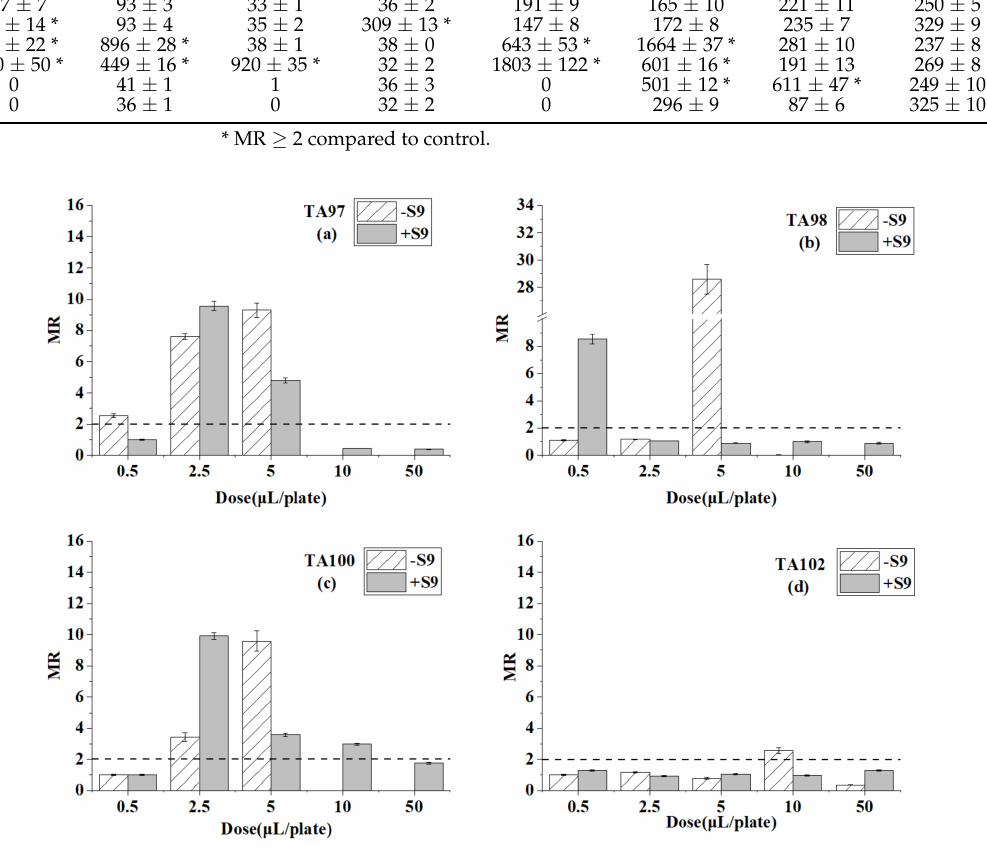
Figure 3. Mutagenesis of trichloroethylene to four strains in the presence and absence of S9 liver extract; ( a ) TA97 strain; ( b ) TA98 strain; ( c ) TA100 strain; ( d ) TA102 strain. The mutagenicity ratio (MR) is the average ratio ( ± SE) from three parallel